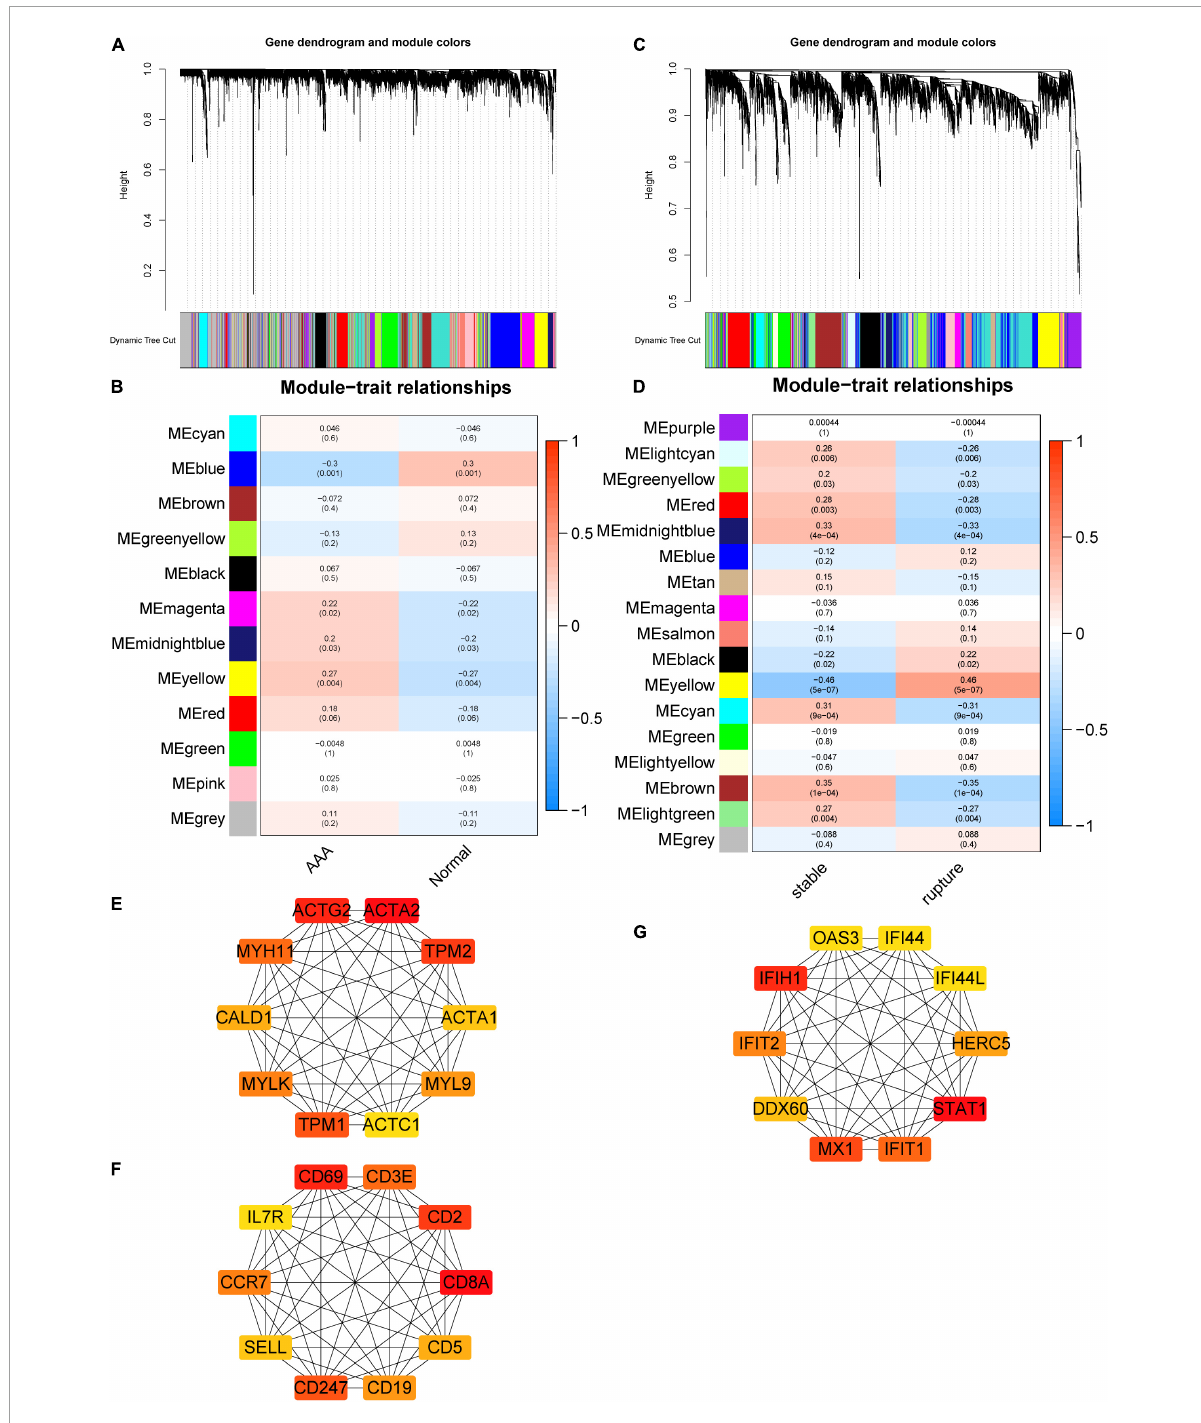
FIGURE2 Construction of AAA- and aortic rupture-related gene co-expression networks using WGCNA and PPI networks of candidate hub genes. (A) Dendrogram and clustering for identification of gene co-expression modules of AAA-related merged dataset 1. (B) Correlation analysis of gene co-expression modules with AAA. The numbers above brackets were correlation coefficients and the numbers in brackets were p -values. (C) Dendrogram and clustering for identification of gene co-expression modules of aortic rupture-related merged dataset 2. (D) Correlation analysis of gene co-expression modules with aortic rupture. The numbers above brackets were correlation coefficients and the numbers in brackets were p -values. (E,F) The PPI networks of candidate hub genes of AAA-related blue module and yellow module, respectively. (G) The PPI networks of candidate hub genes of aortic rupture-related yellow module. AAA, abdominal aortic aneurysm; WGCNA, weighted gene correlation network analysis; PPI, protein–protein